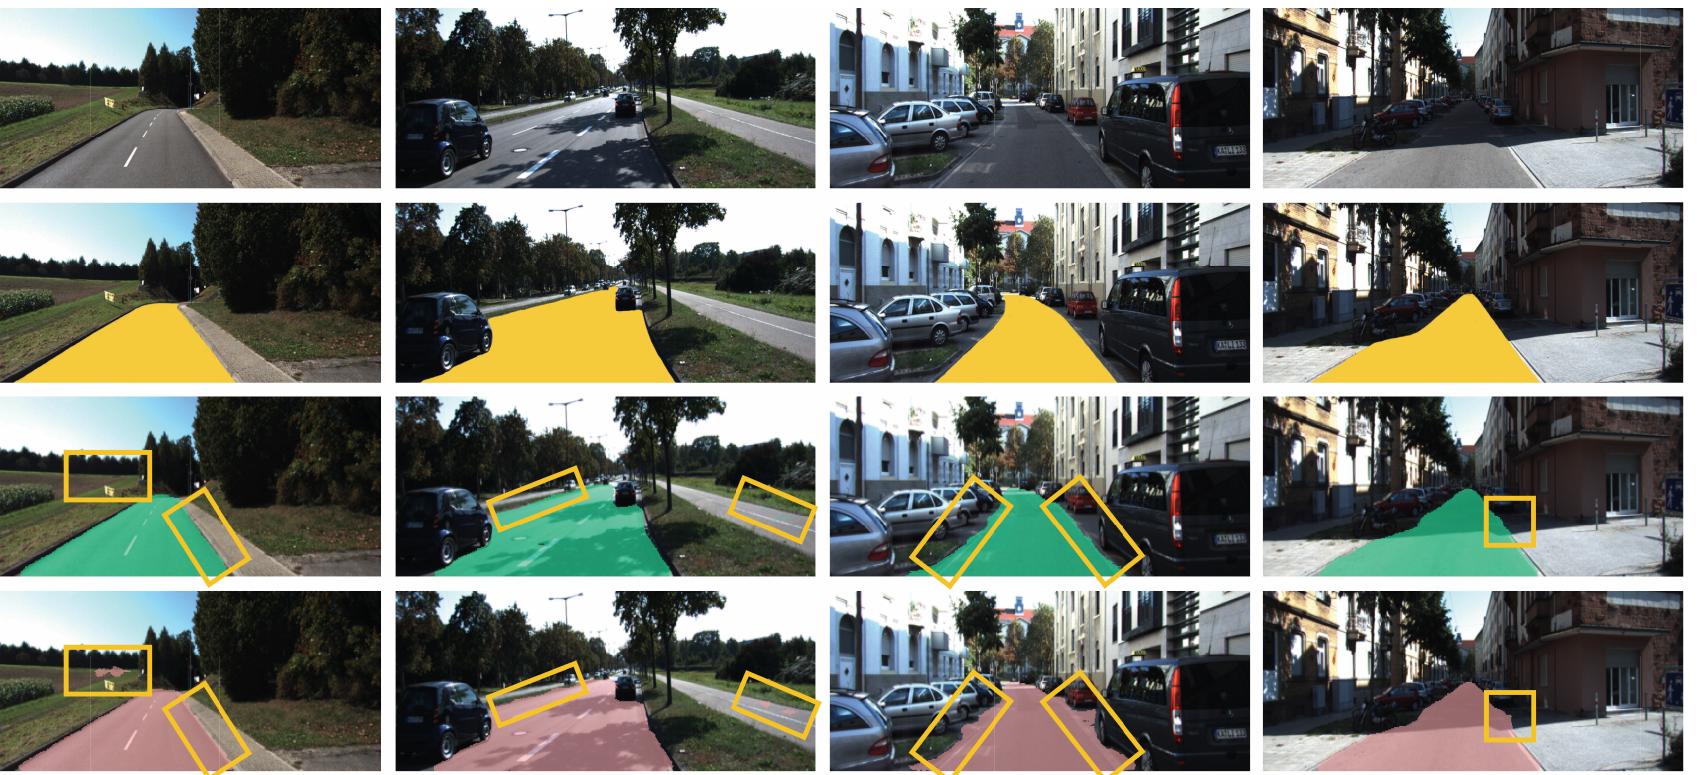
Figure 14. Results of semantic segmentation of the road. First row: some examples of road scenes in various situations. From left to right: Highway clear weather no traffic, highway shadow mix with traffic, urban dim with cars parked, and urban shadow mix with cars parked. Second row: the corresponding road ground truth annotations in yellow overlaid over the original image. Third row: road segmentation by our model FCNx. Row four: road segmentation by UC Berkeley